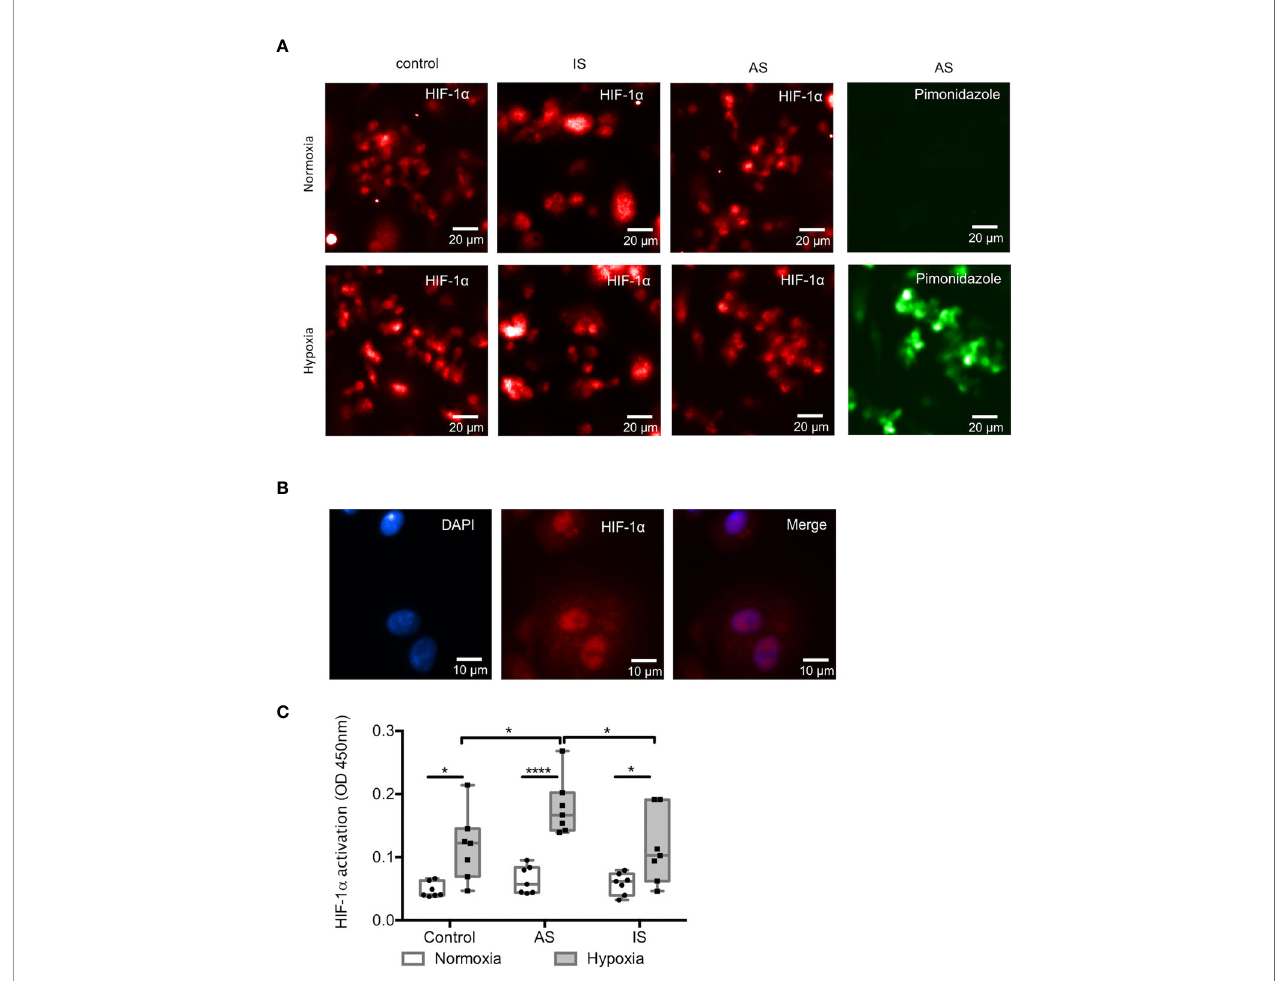
FIGURE 1 | HIF-1 a is activated by hypoxia in MD-macrophages from high active sarcoidosis. (A, B) Representative immuno fl uorescence staining of MD- macrophages. (A) Similar presence of HIF-1 a (in red) in controls and in high active pulmonary sarcoidosis (AS) and low active or inactive sarcoidosis (IS) patients in both normoxia and hypoxia. Pimonidazole staining (in green) of MD-macrophages from AS is absent in normoxia (magni fi cation x200). (B) Nuclear staining with DAPI (in blue) and accumulation of HIF-1 a (in red) in MD-macrophages. Overlay image showing HIF-1 a nuclear localization (magni fi cation x400) (same results were found in 3 patients and 3 controls). (C) HIF-1 a activation (measured as OD 450nm) assessed by TransAM ® HIF-1 a in controls, AS and IS patients, after 24hrs of normoxia or hypoxia. Results are expressed as box plot showing 25 th and 75 th percentile and median, each point indicates a patient and/or control (n= 7/group). *p < 0.05; ****p < 0.0001 in two-way ANOVA-repeated measures with Sidak post-hoc